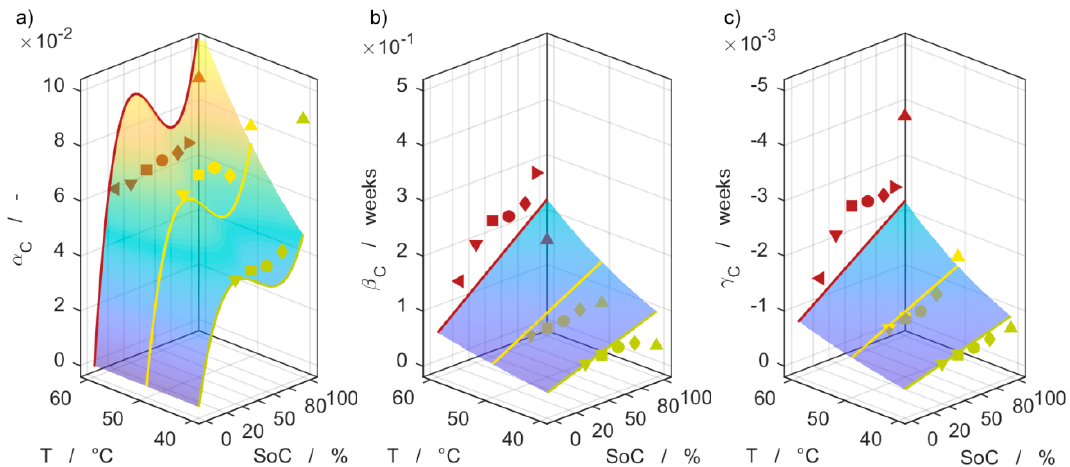
Figure 5. Comparison of the fit coefficients obtained from the 2D and 4D fits of the C C/20 degradation. The markers indicate the results of the individual 2D fits with constant ( a ) α C , ( b ) β C and ( c ) γ C . The colored lines represent the characteristic SoC pattern of the overall 4D fit evaluated at the three temperatures. The color shaded plane shows the SoC and Arrhenius temperature dependency of the 4D fit.